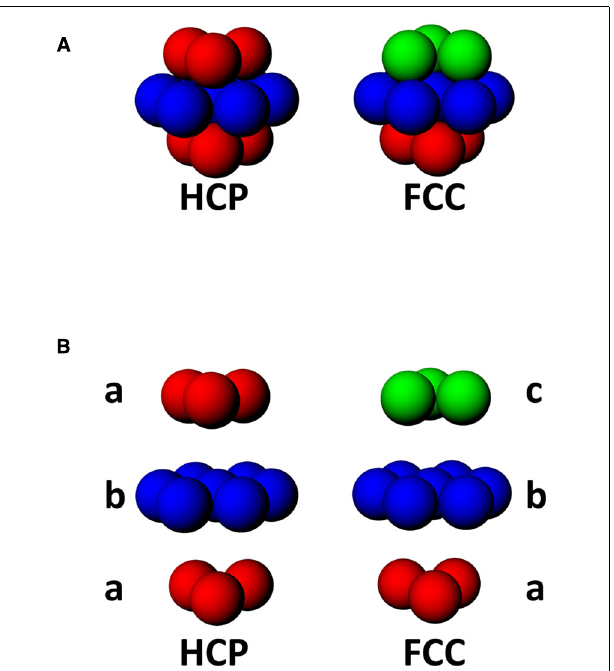
FIGURE 6 | (A) Two forms of close-packing of spheres, hexagonal close-packed (HCP) or face-centered cubic (FCC). (B) Exploded view of HCP and FCC lattices, showing that HCP involves alternating layers a and b, while FCC comprises triplets of layers, a, b, and c, where c is a 180° horizontal rotation of